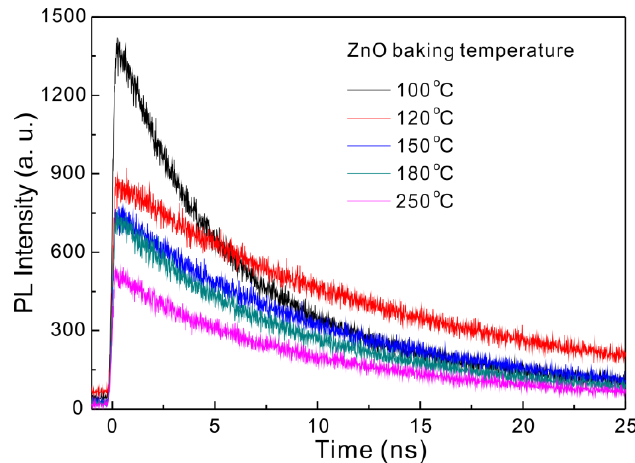
Figure 6. The time ‐ resolved photoluminescence decays of MAPbI 3 /ZnO (~20 nm)/FTO glass with the different baking